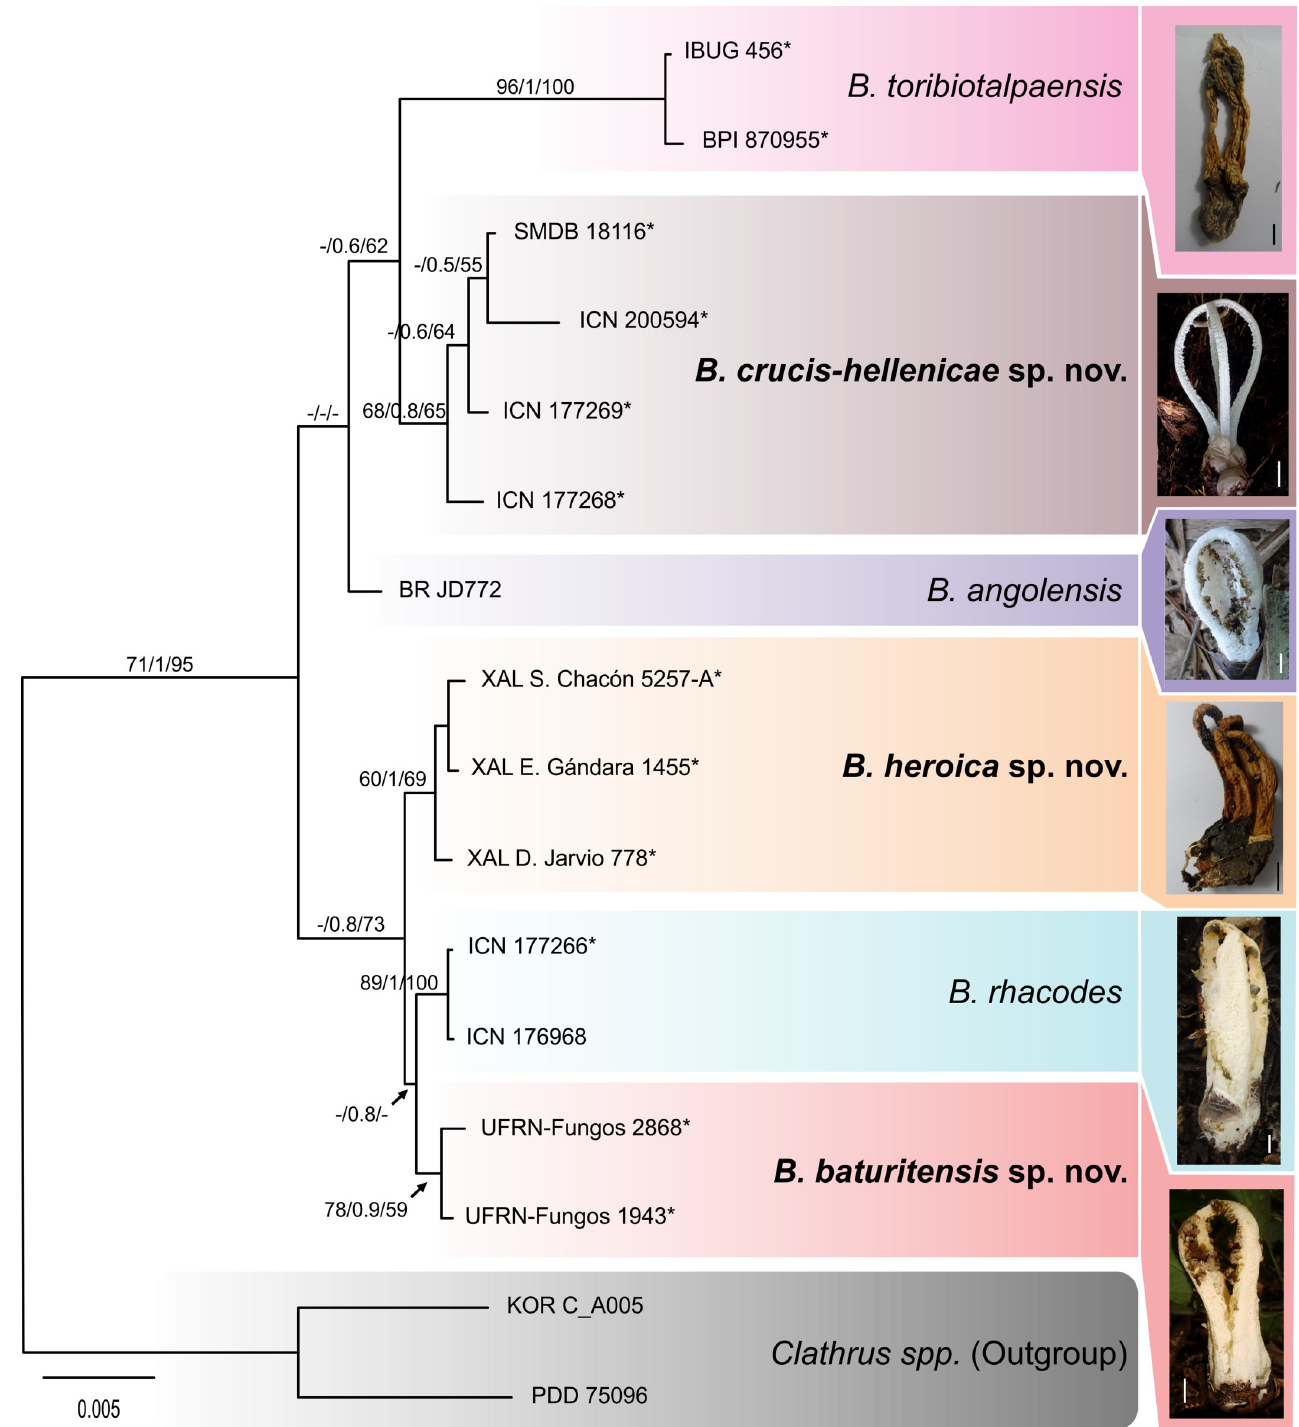
Fig 1. Bayesian tree from concatenated matrix (ITS1/5.8S/ITS2/LSU/ ATP 6/ RPB 2/ TEF -1 α ). Numbers above branches indicate maximum parsimony bootstrap (MPbs), posterior probability (PP) and maximum likelihood bootstrap (MLbs) values. Asterisks represents type species. To the right, basidiomata of each species. Scale bars = 10